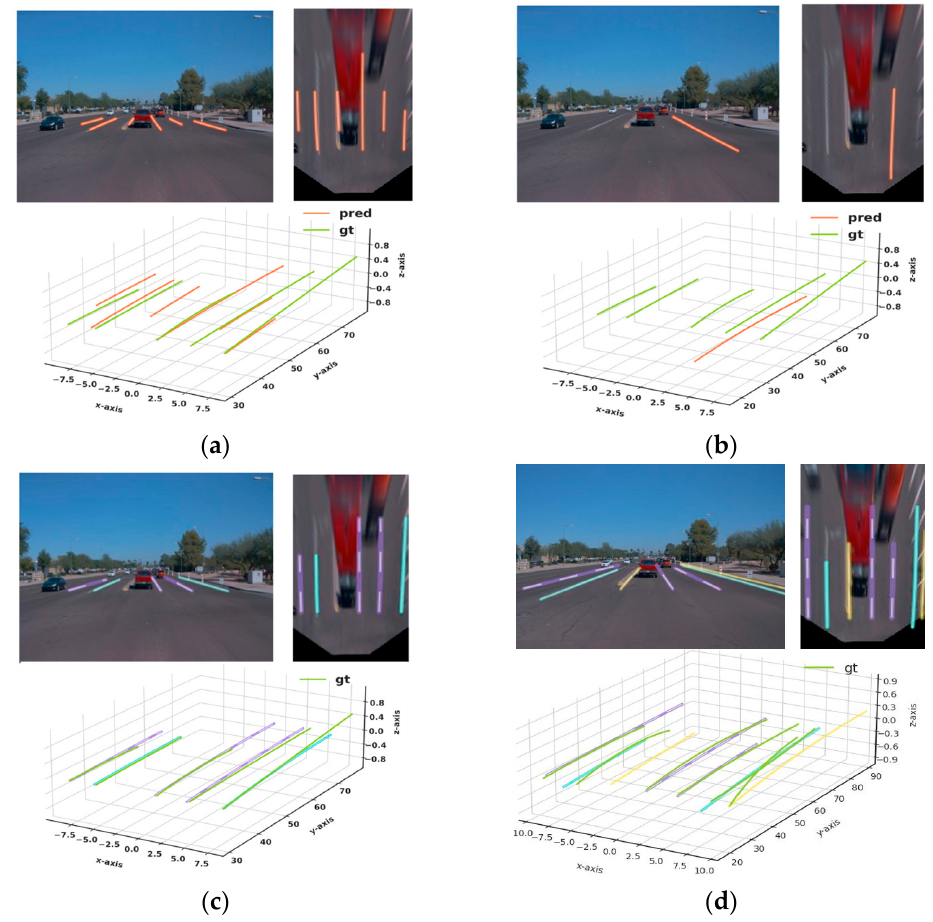
Figure 7. Qualitative comparison between: ( a ) 3D-LaneNet [34], ( b ) Gen-LaneNet [35], ( c ) PersFormer [13], and ( d ) proposed method on intersection case.